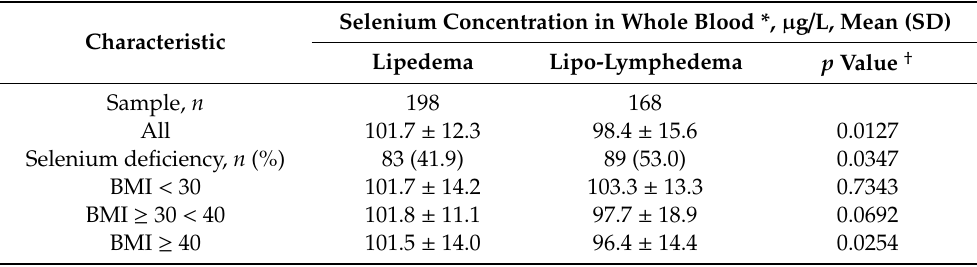
Table 3. Selenium concentration in whole blood in lipedema and lipo-lymphedema. Characteristic